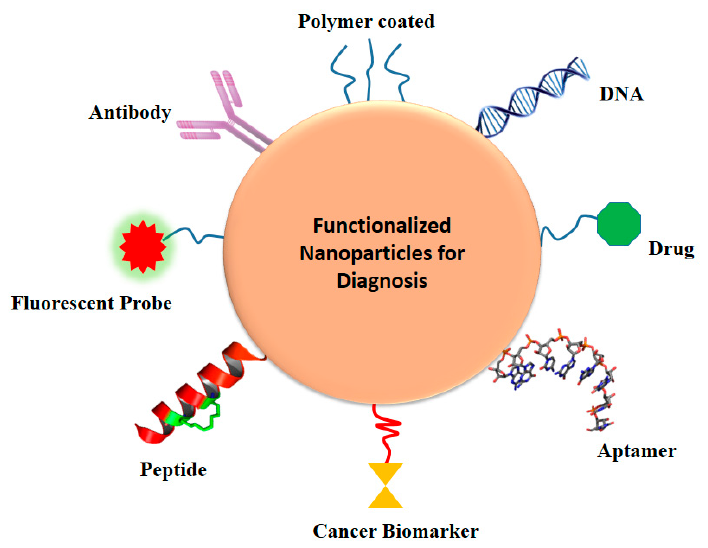
Figure 5. Schematic representation of multifunctional NPs in the diagnosis of brain infections.